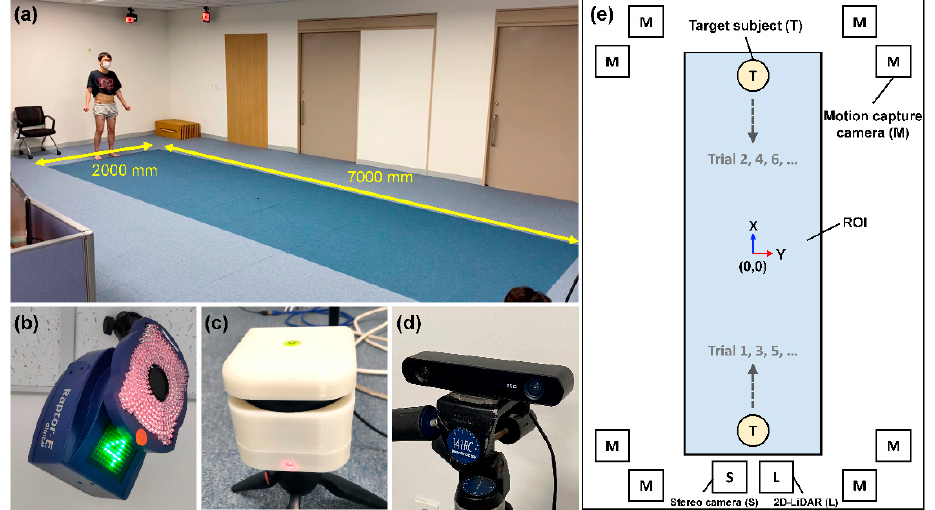
Figure 1. Test environment and instrument settings for validation of two-dimensional light detection and ranging (2D-LiDAR)-based gait analysis. ( a ) Gait analysis room showing region of interest (ROI) area of motion capture system marked as blue on the floor. ( b ) One of eight near infrared cameras of motion capture system. ( c ) 2D-LiDAR sensor. ( d ) Stereo camera. ( e ) A schematic of a test environment with spatial coordinates based on motion capture system. The center of ROI is denoted as (0 mm, 0 mm). The sensor positions of 2D-LiDAR and stereo camera are shown simultaneously.